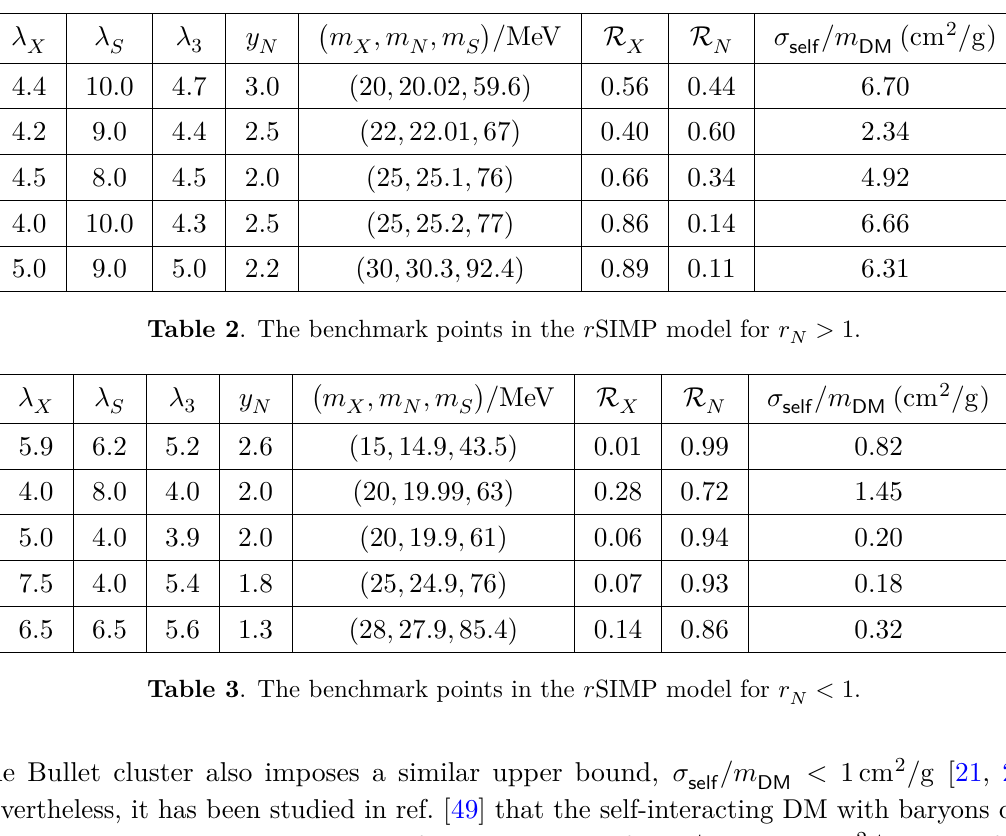
Table 3 . The benchmark points in the r SIMP model for r